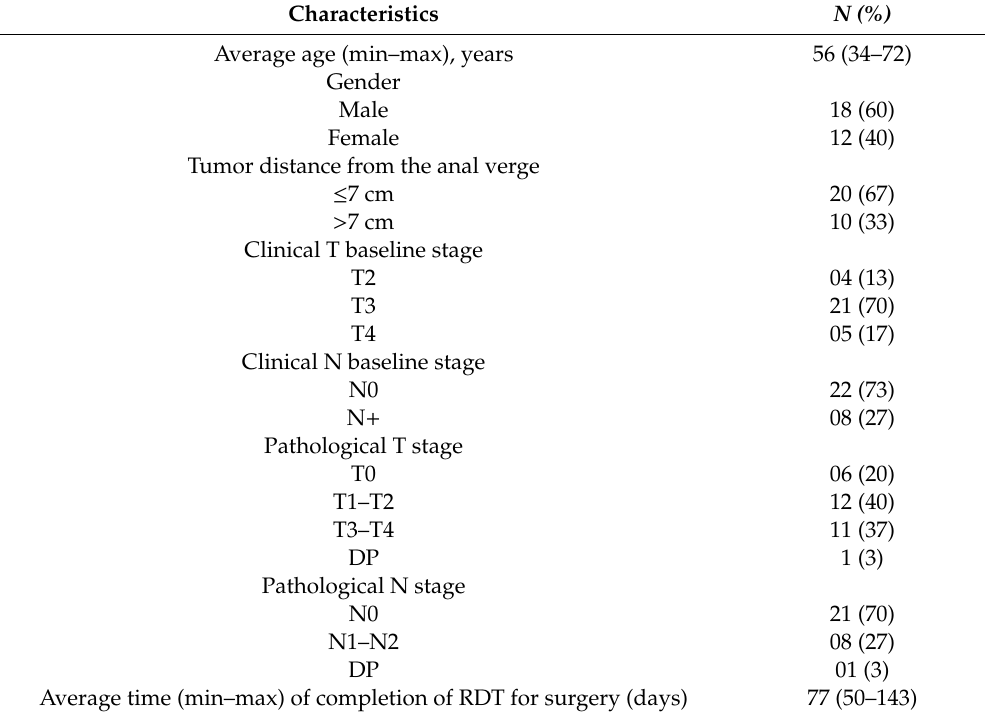
Table 1. Patient